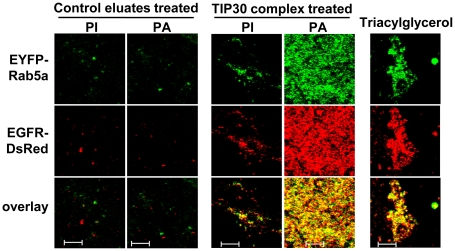
Fatty acylation of phosphatidic acid promotes vesicle aggregation.Lipids were extracted after incubating 100 nmol PA or phosphatidylinositol (PI) with 100 nmol arachidonic acid the TIP30 complex or control eluates. Lipids were resuspended in homogenization buffer by sonication and were mixed with EGFR-DsRed and EYFP-Rab5a vesicles in in vitro fusion buffer at 37°C. Resulting vesicles were spotted on glass slides and images were taken using confocal microscope. Scale bars, 5 µm.